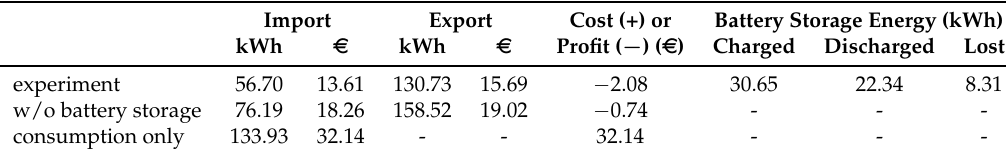
Table 7. Evaluation of second test period (30 March at 00:00 to 5 April at 00:00). All values except for the cost/profit are given as absolute values. The overall energy generated by the photovoltaic plant during the test period is 216.67